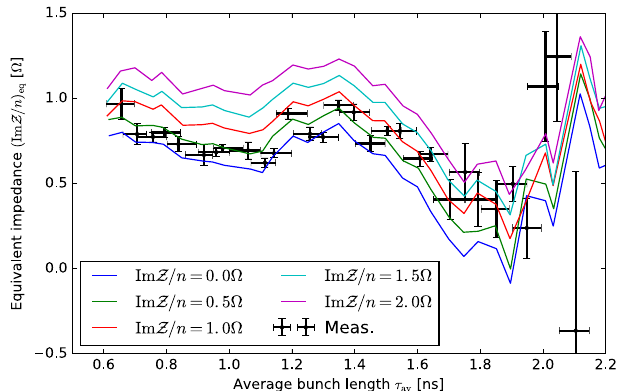
FIG. 16. Measured equivalent impedance ð Im Z =n Þ the Q20 optics compared with simulations (colored lines) adding a variable amount of inductive impedance in the range Im Z =n ¼ ð 0 − 2 Þ Ω to the full SPS impedance